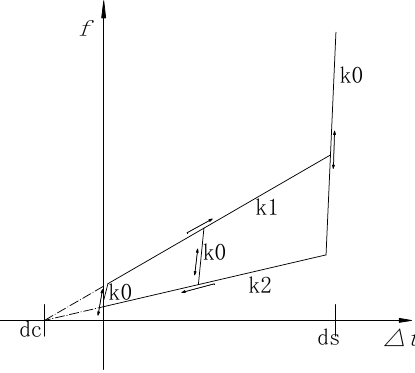
Figure 13. Force–deformation curve of friction spring damper.